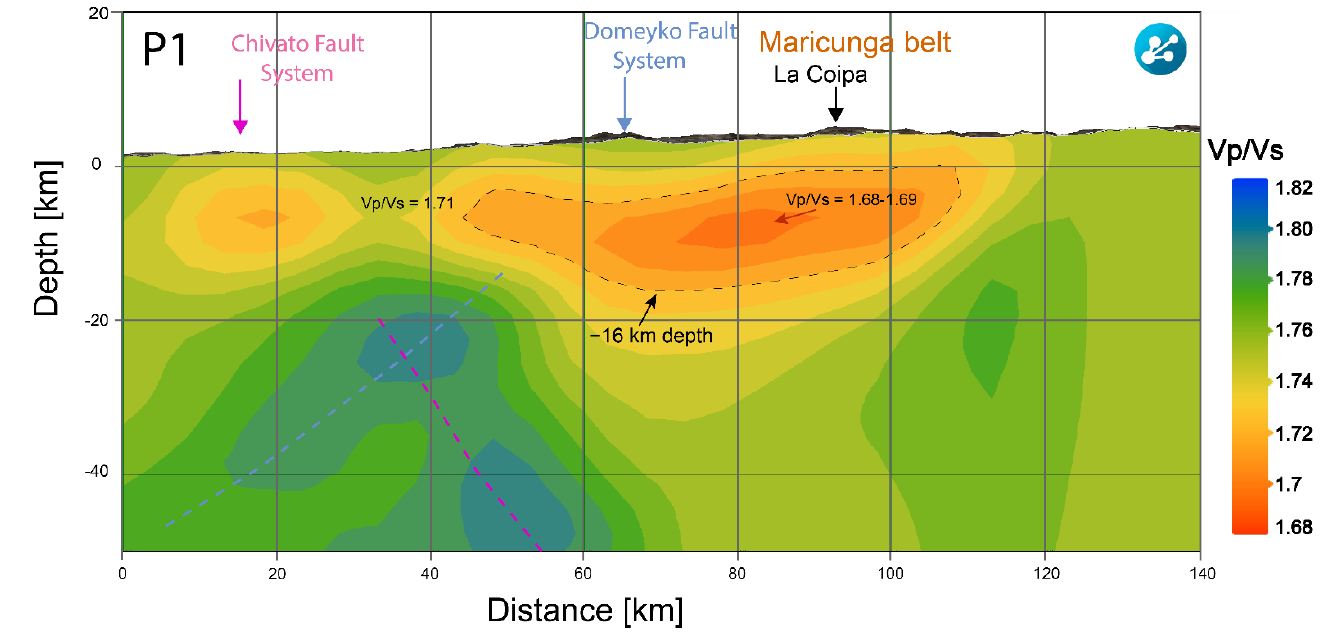
Figure 4. Cross section of the Vp/Vs model (with color intervals of 0.01) passing through the La Coipa deposit (26°49 ′ ) (see Figure 1). The locations of the Chivato and Domeyko Fault Systems are marked with pink and light blue arrows, respectively. The location of the La Coipa mine is marked with a black arrow. The location of the MB is marked with red letters. Light blue and pink dashed lines represent a possible deep projection of the Domeyko and Chivato Fault Systems, respectively.